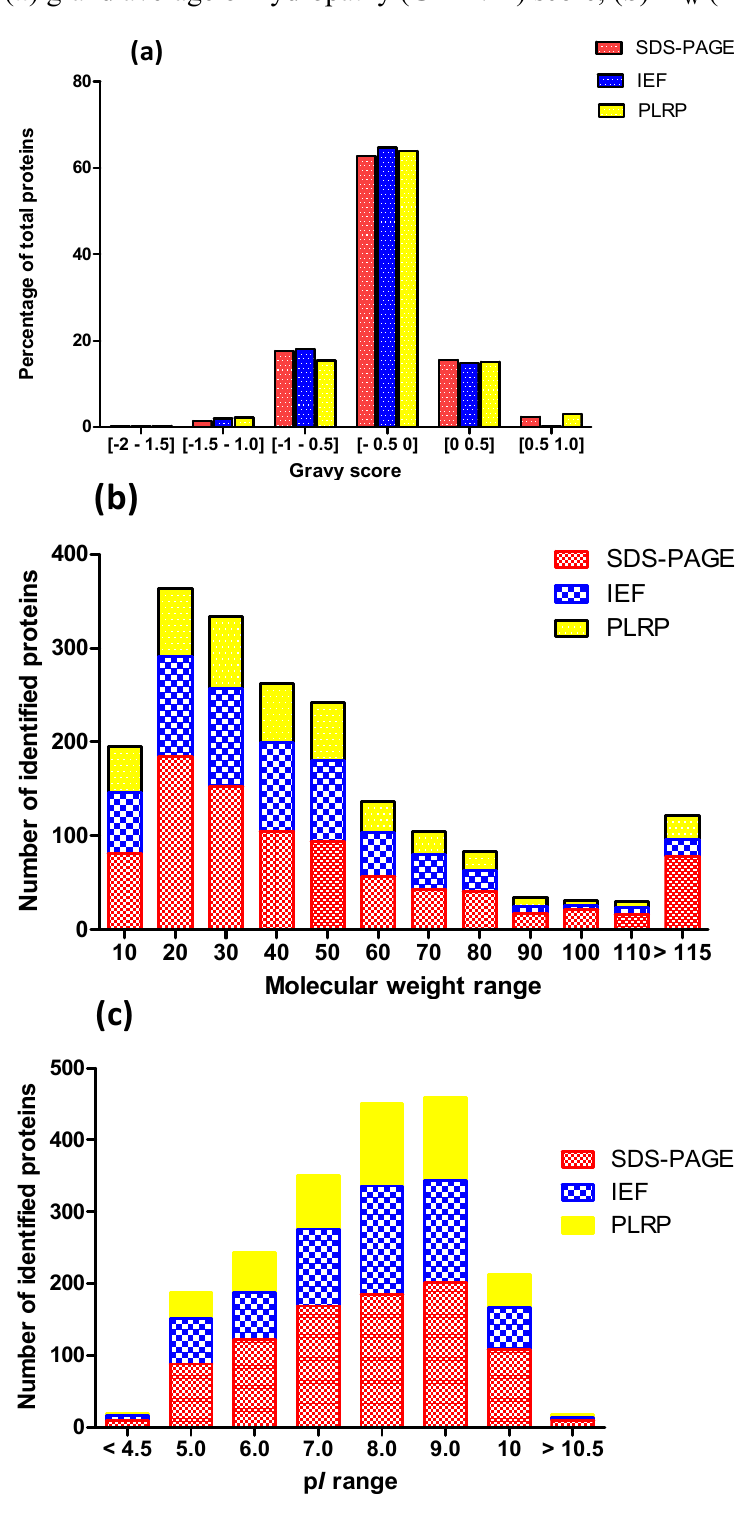
Figure 3. Distribution of intrinsic properties of the mitochondrial proteins identified with each platform. ( a ) grand average of hydropathy (GRAVY) score; ( b ) M